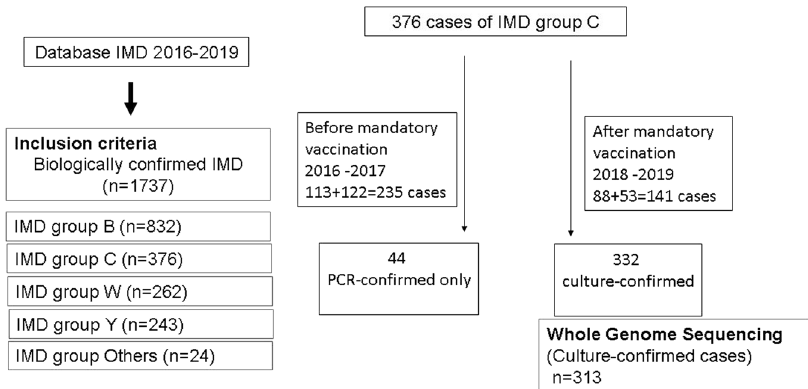
Fig. 7 Study fl owchart. IMD: invasive meningococcal